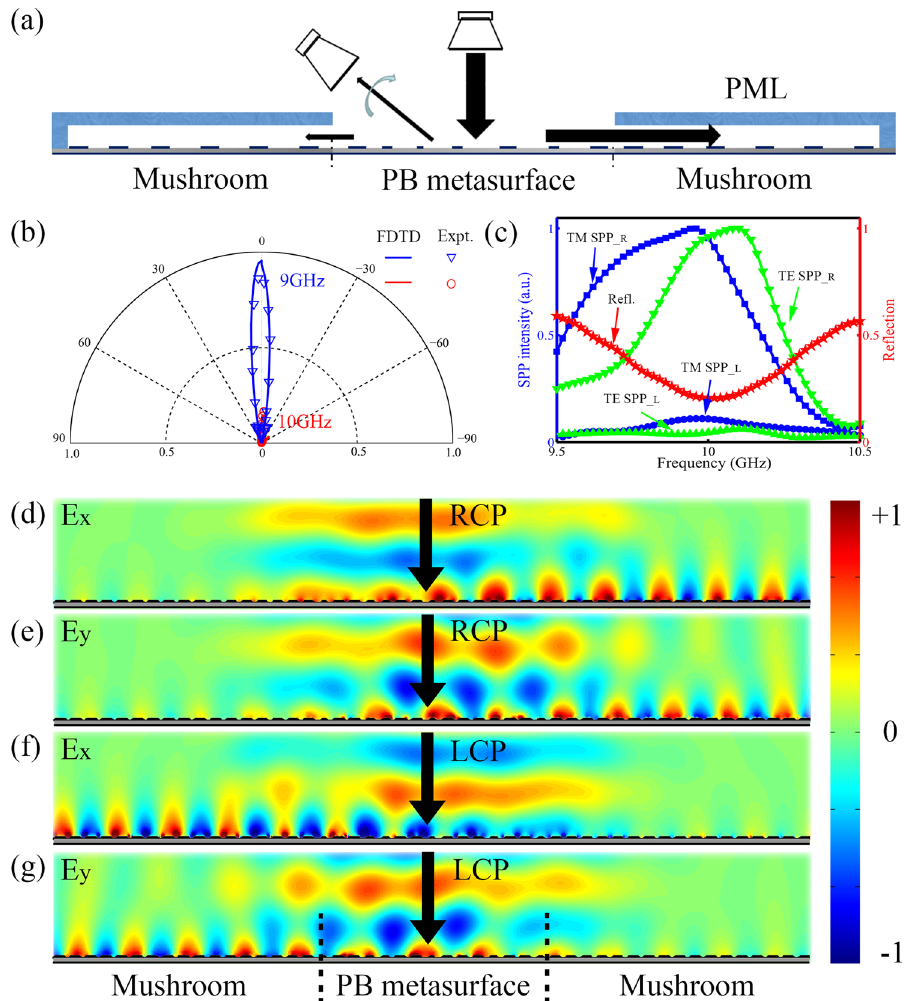
Figure 5. Far-field characterizations of the high-efficiency PB meta-coupler. ( a ) Schematics of the experimental setup for the far-field measurement. Here, we use a right-handed CP antenna to illuminate normally the central PB metasurface and use another CP antenna to collect the scattered field intensity at different reflection angles. ( b ) Measured and simulated normalized angular far-field distributions of scattered waves while the PB meta- coupler is illuminated by input CP wave at 9 GHz and 10 GHz. ( c ) The integrated total reflection R (red, right axis) and the excited SPP intensities (TE SPP_L, TM SPP_L, TE SPP_R, and TM SPP_R) above the left-side and right-side mushrooms (left axis). ( d – g ) FEM simulated E x and E y field distributions (real part) inside the SPP meta-coupler shined by a normally incident RCP ( d , e ) or LCP ( f , g ) Gaussian beam with 2 λ waist-width at 10 GHz. The SPP excitation efficiency, defined as the ratio between the power carried by the generated directional SPP and that carried by the incident CP Gaussian beam, is about 81% in our